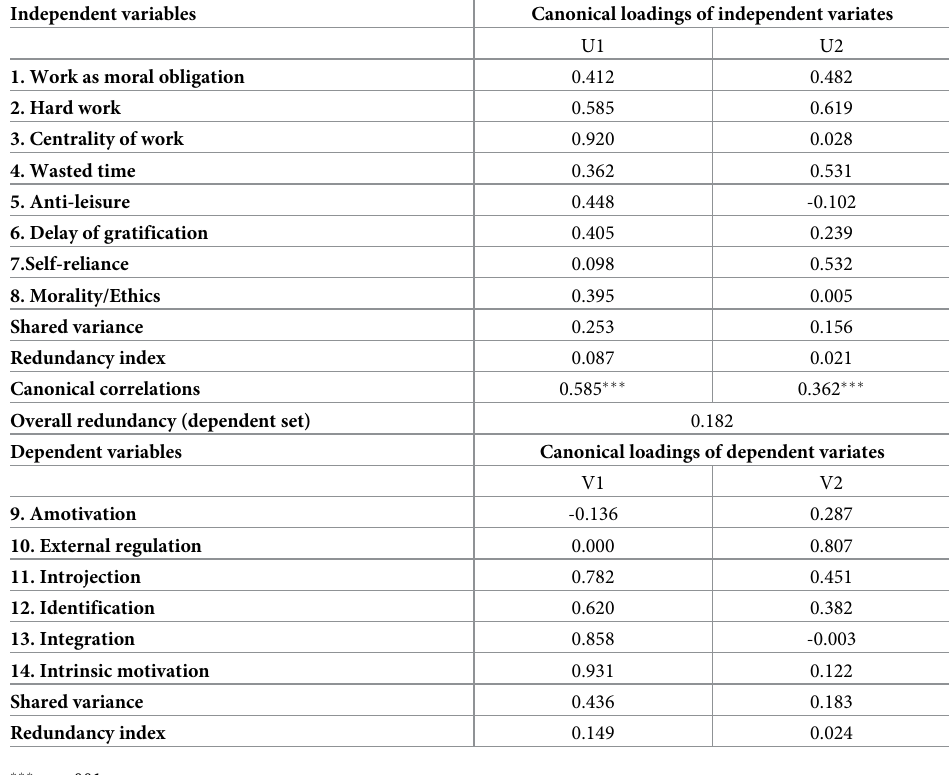
Table 3. Work ethic and motivation. Results of CCA for two canonical functions: canonical correlations, loadings, shared variance and redundancy analysis of independent and dependent canonical variates. Independent variables Canonical loadings of independent variates U1